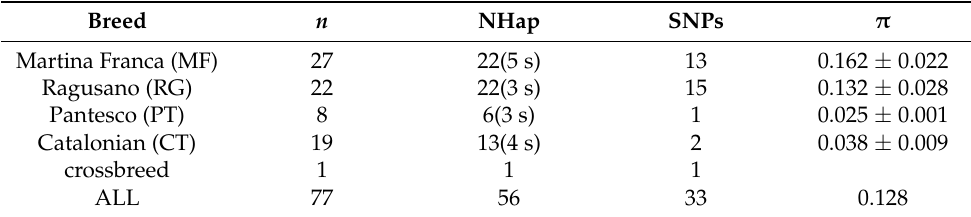
Table 1. D-loop nucleotide polymorphisms and molecular diversity indices per breed tested in the